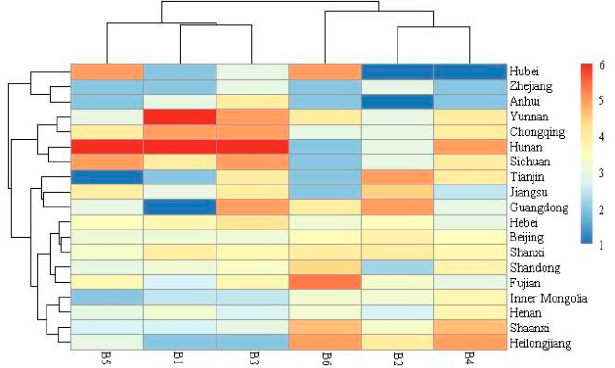
Figure 3. The heatmap of respondents’ liking scores for six kinds of vinegar in different regions. The code of vinegar corresponds with Table 1. These regions are explained in the supplementary data (Figure S2).